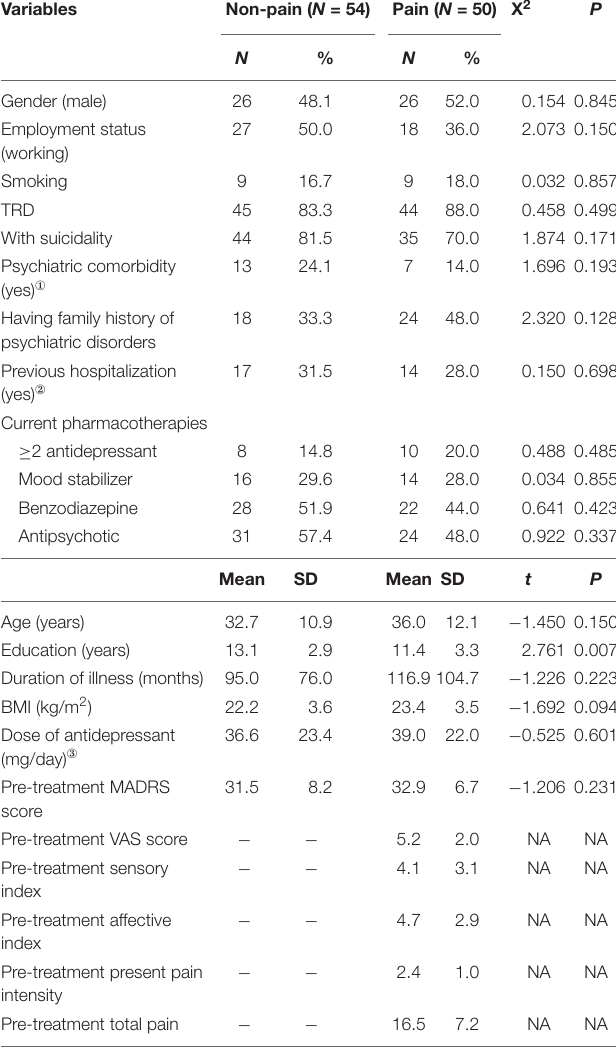
MDD, Major Depressive Disorder; TRD, Treatment-resistant Depression; BMI, body mass index; MADRS, Montgomery-Åsberg Depression Rating Scale; VAS, visual analog scale; NA, not applicable. (cid:172) Comorbidity of an Axis I anxiety disorder, obsessive-compulsive disorder, phobia, or panic disorder. (cid:173) Previous hospitalization due to mental health